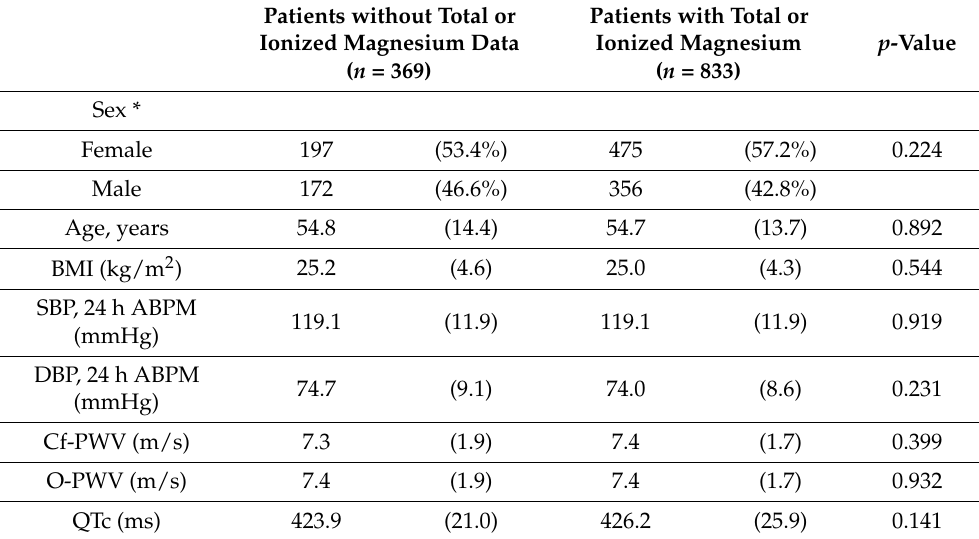
Table A3. Comparisons between the investigated population and the population excluded because of missing values.